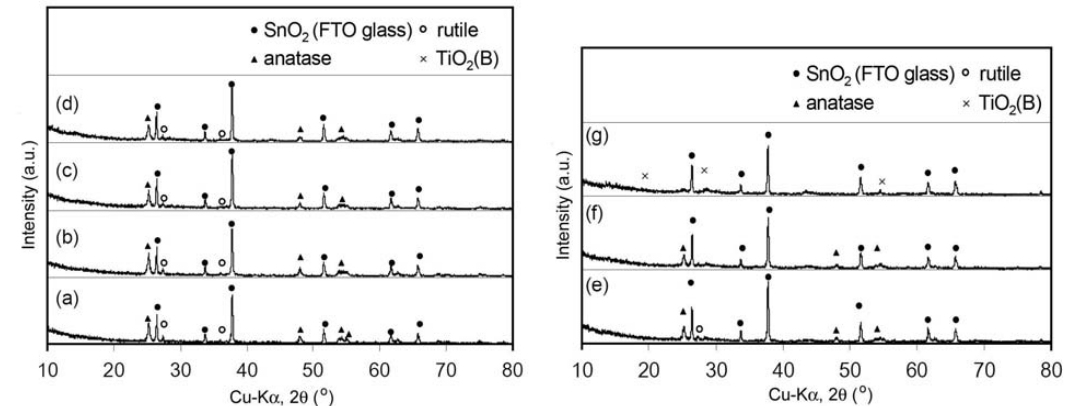
Fig. 7 XRD patterns taken from the DSC surface: TiO 2 (B)nanowire contents in the precursor paste were (a) 0 wt%, (b) 10 wt%, (c) 20 wt% (d) 30 wt%, (e) 40 wt%, (f) 50 wt% and (g) 100 wt%,